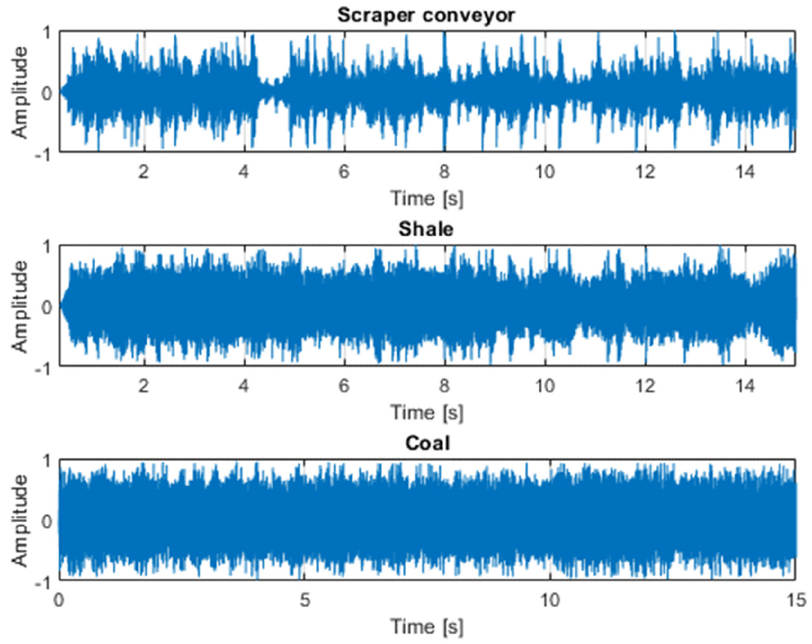
Figure 2. Graphs of recorded sound samples.